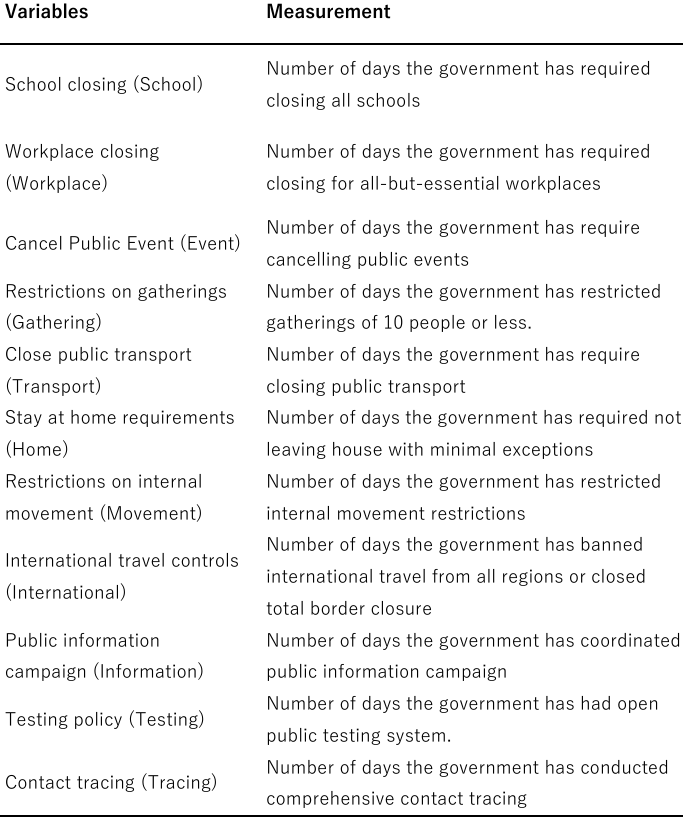
Table 1. Contents of Coronavirus Government Response